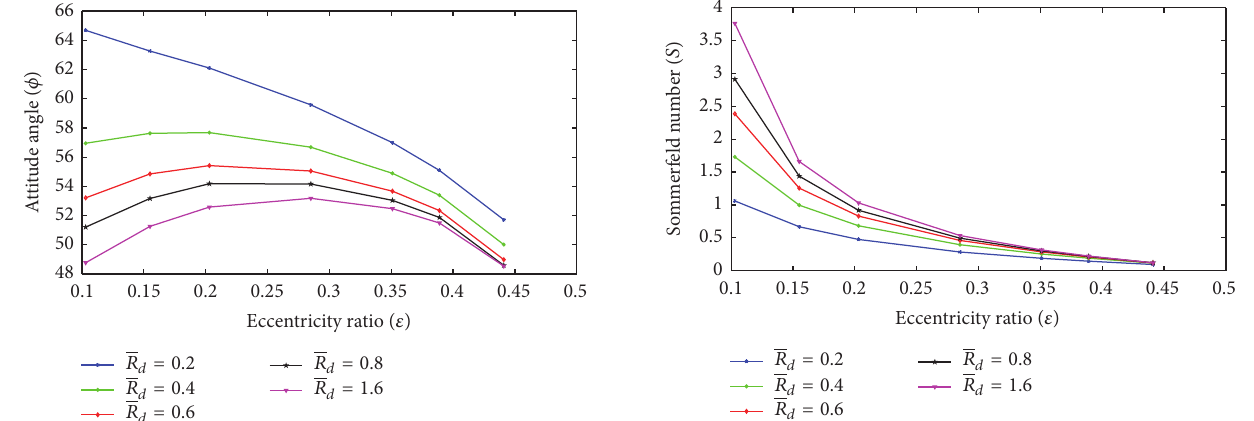
Figure 4: Effect of relief track depth ratio on attitude angle.